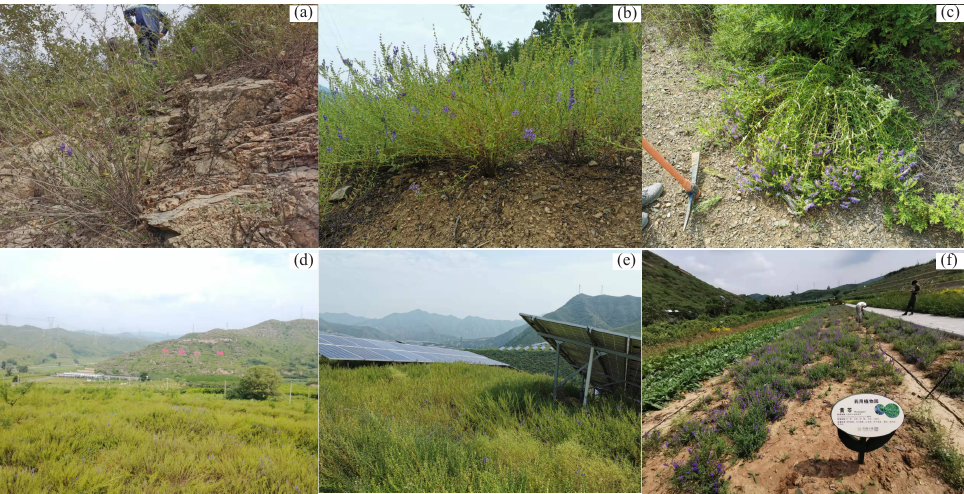
Figure 2. Field photos of Scutellaria baicalensis in various habitats; ( a – c ) Natural grown habitats (NGHs); ( d , e ) Artificial planting habitats (APHs); ( f ) Biomimetic cultivation habitats